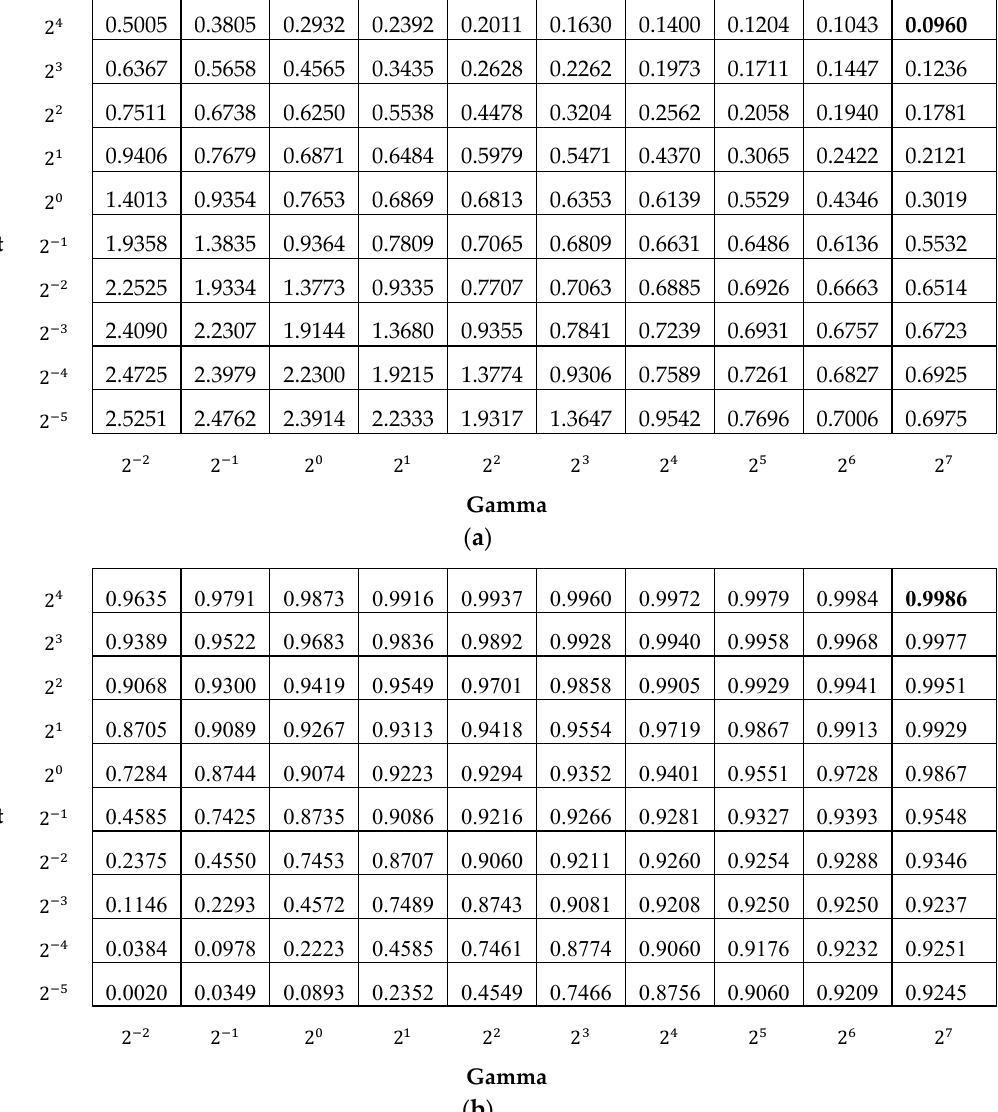
Figure 15. The mean score in the edge area of: ( a ) positioning accuracy and ( b ) CV.